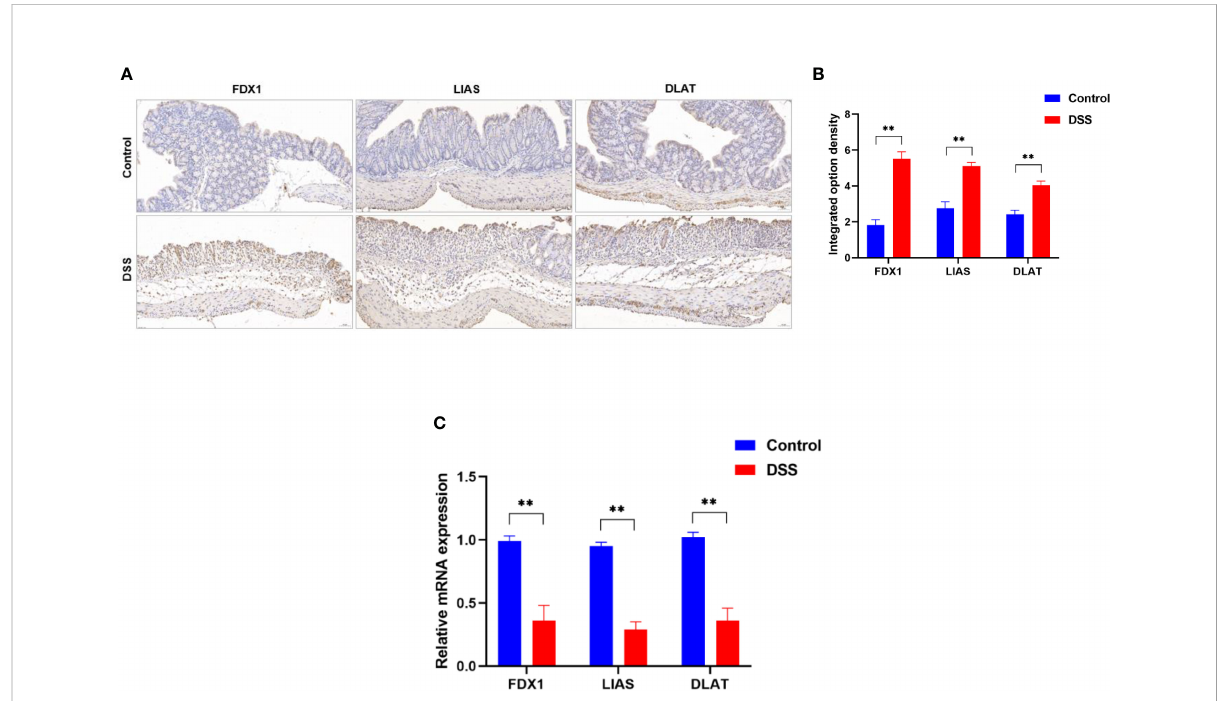
FIGURE 9 Altered expression of cuproptosis-related genes in DSS-induced colitis. (A) representative images of immunohistochemical staining of FDX1, LIAS, and DLAT in colonic tissues (200× magni fi cation, n = 3). (B) The integrated option density was used in order to quantify FDX1, LIAS, and DLAT proteins. (C) FDX1, LIAS, and DLAT expression levels in colon tissues were detected by qRT-PCR (n = 6). **p < 0.005 compared to the